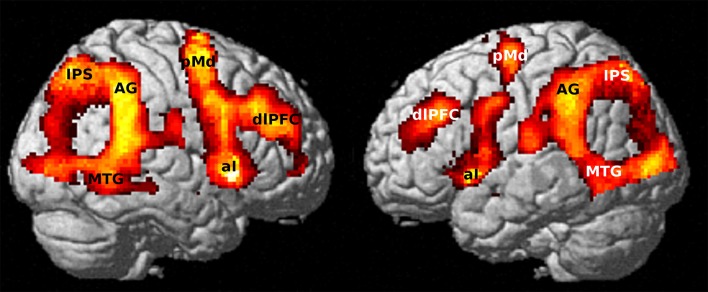
Activated network for to the alarm stimulus (“O”) from the first fMRI session (T1) by conjunction of conditions GO & NOGO (n = 113). Maximum activation peaked in the right AG (p < 10−10 FWE corrected; 20 voxels extent threshold).